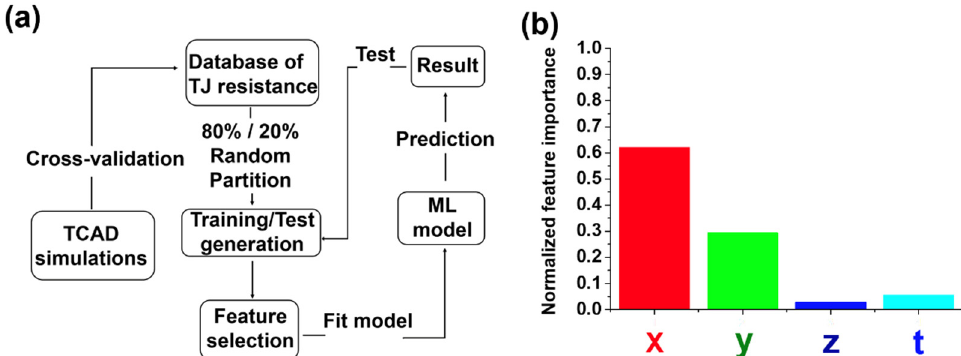
Figure 2. ( a ) Process flow of the ML model for TJ resistance prediction. ( b ) Feature importance retrieved from the XG-Boost model that was learned from the 2260 data samples.